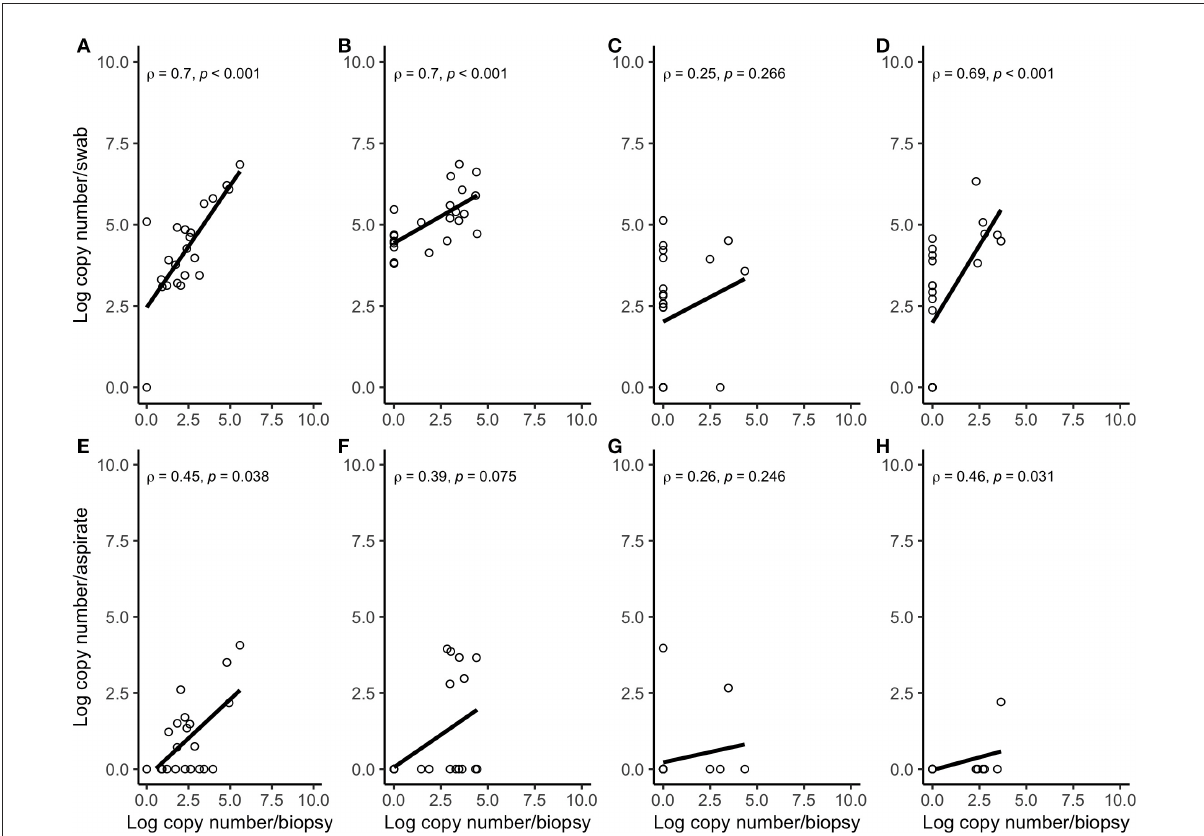
FIGURE4 Spearman correlation plots between the amount (log-transformed copy numbers) of Porphyromonas levii (A) , Bacteroides pyogenes (B) , Fusobacterium necrophorum (C) , and Fusobacterium mortiferum (D) in swabs and biopsies of bovine DD active M2 lesions, and P. levii (E) , B. pyogenes (F) , F. necrophorum (G) , and F. mortiferum (H) in aspirates and biopsies of bovine DD active M2 lesions. There were significant correlations between the quantity of P. levii, B. pyogenes, and F. mortiferum in biopsies and swabs and P. levii , F. mortiferum in biopsies